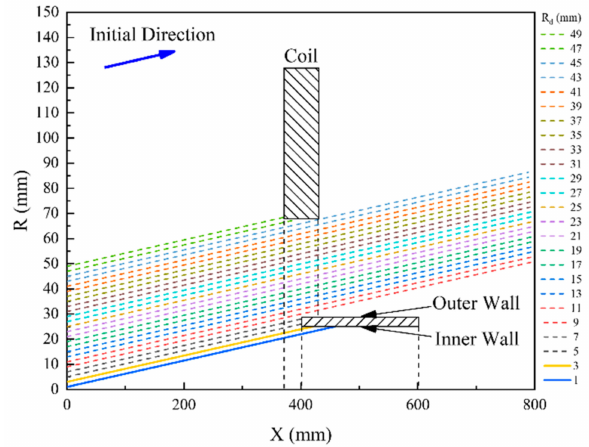
Figure 9. Trajectories of ions with emission angle of 3 ◦ under no magnetic